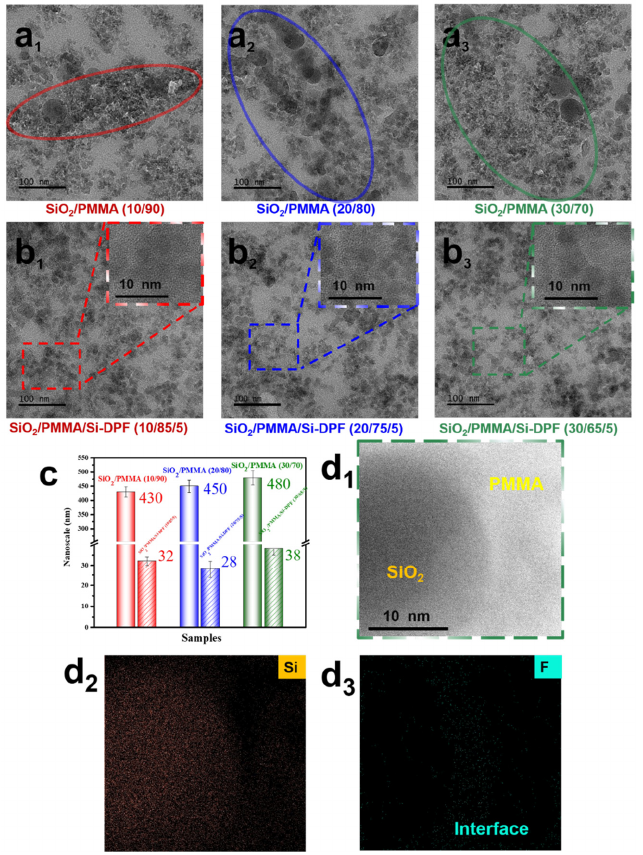
Figure 2. TEM images of SiO 2 /PMMA composites. ( a 1 ) SiO 2 /PMMA (10/90), ( a 2 ) SiO 2 /PMMA (20/80), ( a 3 ) SiO 2 /PMMA (30/70), ( b 1 ) SiO 2 /PMMA/Si-DPF (10/85/5), ( b 2 ) SiO 2 /PMMA/Si-DPF (20/75/5), and ( b 3 , d 1 ) SiO 2 /PMMA/Si-DPF (30/65/5). ( c ) SiO 2 particle size of SiO 2 /PMMA com- posites. ( d 2 , d 3 ) Elemental mapping images of Si and